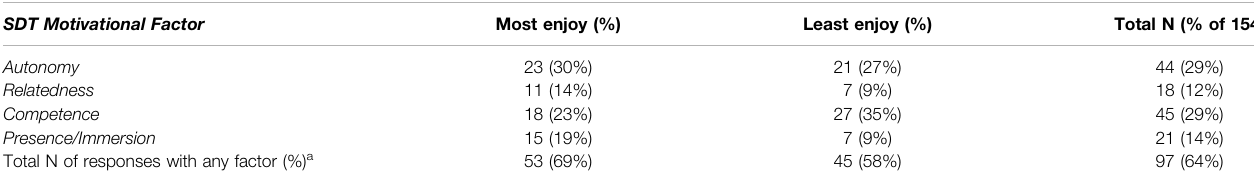
TABLE 3 | Prevalence of SDT factors participants used to describe notable qualities of playing Academical